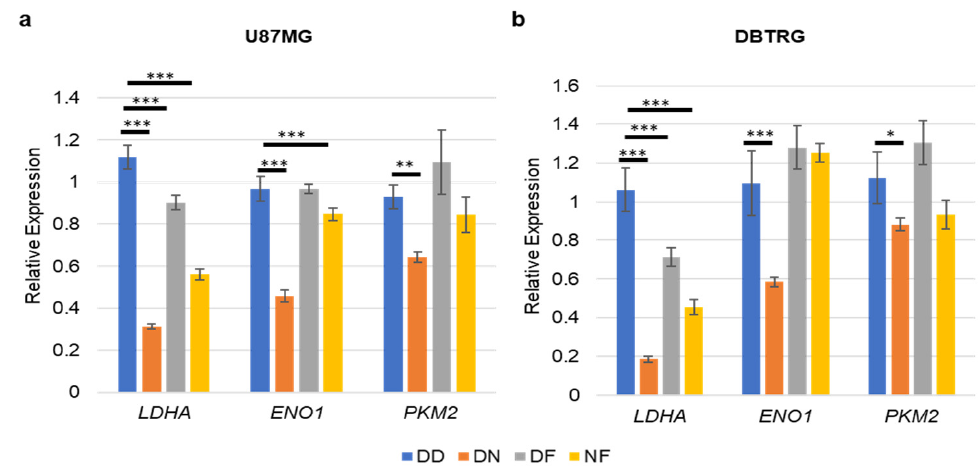
Figure 5. FOXO1 inhibition partially suppressed NVP-BEZ235 induction of glycolytic genes. ( a ) U87MG and ( b ) DBTRG. The relative expression of the genes was analyzed in DD-, DN-, DF-, and NF-treated samples. DD: DMSO; DN: DMSO+NVP-BEZ235 (1 µ M); DF: DMSO+FOXOi (1 µ M AS1842856); NF: NVP-BEZ235+FOXOi (1 µ M of each drug). The error bars represent the standard deviation of the genes. The p -values were calculated by one-way ANOVA followed by Tukey’s test (*, p < 0.05; **, p < 0.01, ***, p < 0.001).